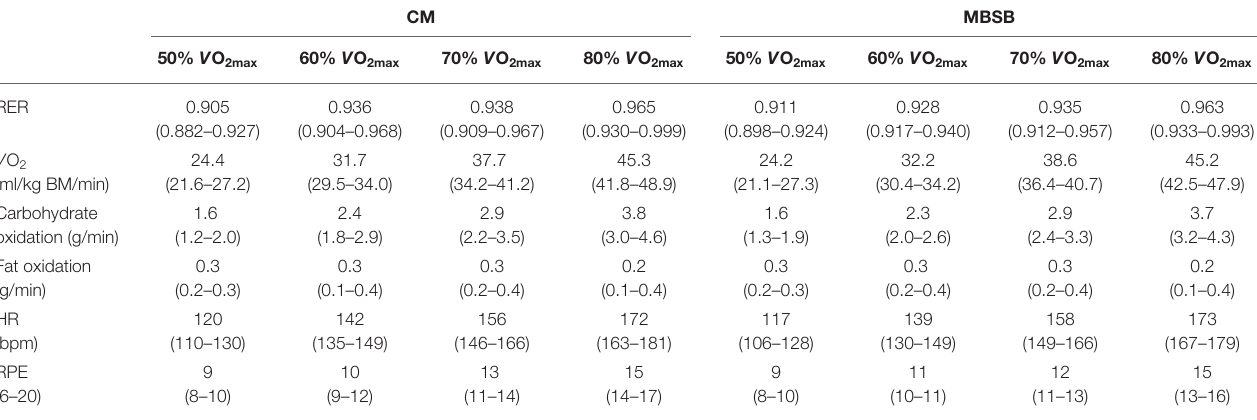
TABLE 4 | Physiological and performance outcomes graded intensity breath-by-breath testing at 50–80% V O 2max and 1h self-paced distance test, following the consumption of a whole food dairy milk beverage (CM) and a reconstituted milk based supplement beverage (MBSB) after 2h HIITthe previous